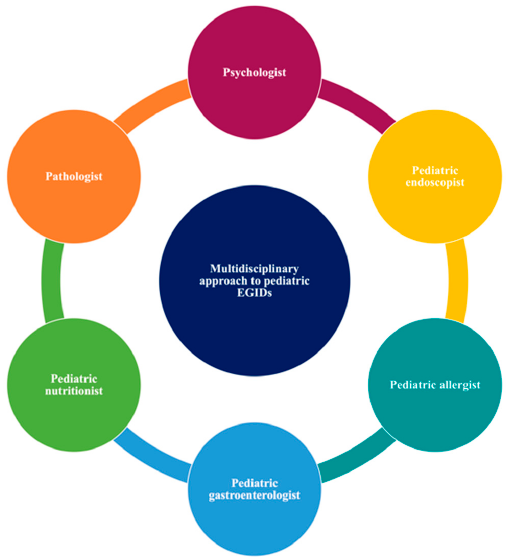
Figure 2. The multidisciplinary approach of children and adolescents with eosinophilic gastrointestinal disorders.